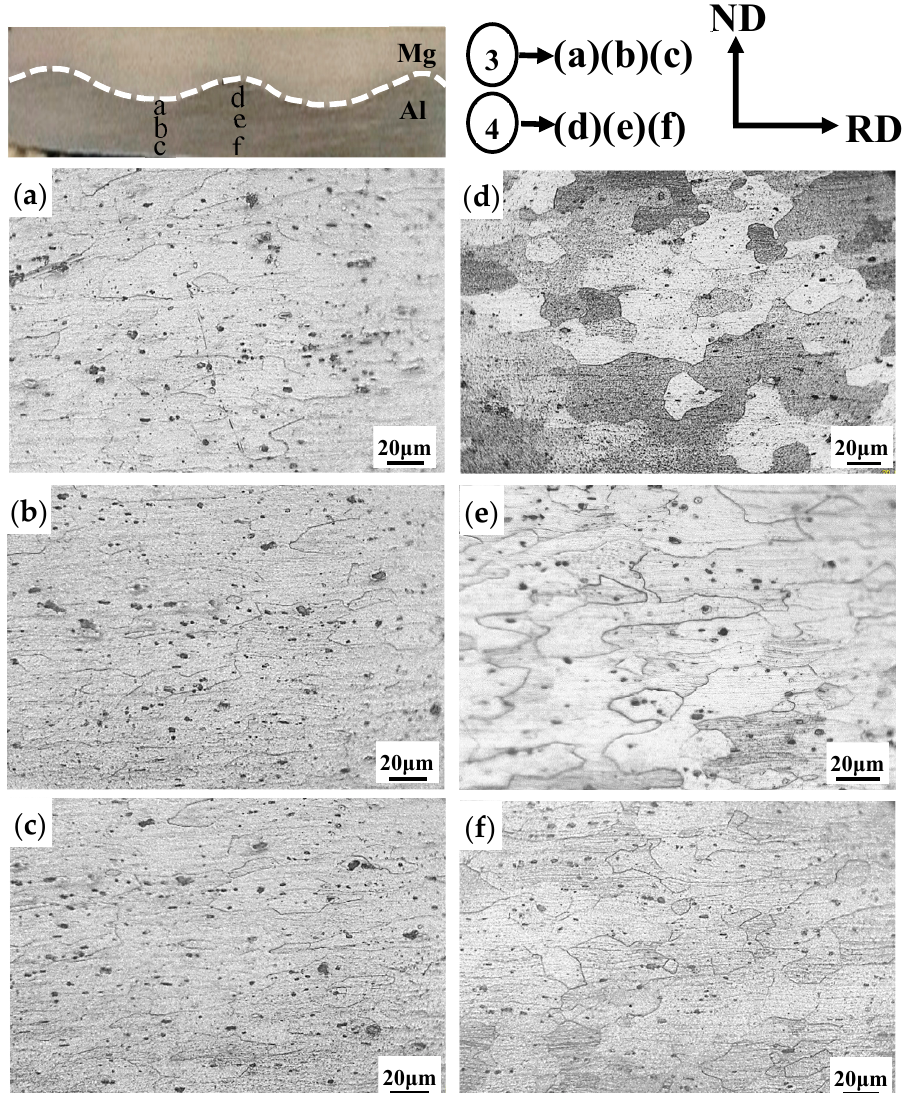
Figure 11. Microstructure of the 5052 of as-rolled CFR Mg/Al laminated composite. ( a – c ) Position 3; and ( d – f ) position 4.